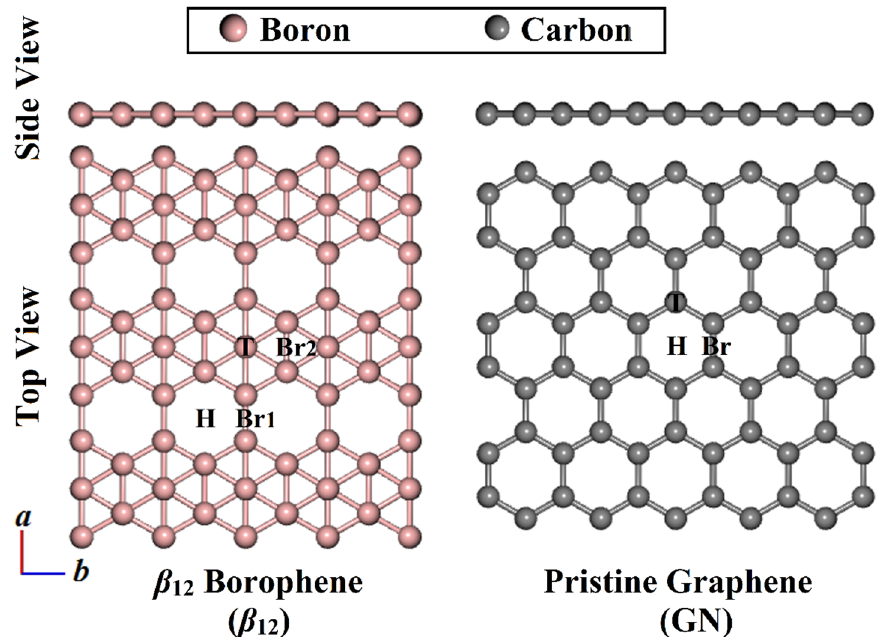
Figure 2. Side and top representations for optimized structures of 3 × 4 × 1 β 12 and 6 × 5 × 1 GN with the modeled adsorption sites. T, Br, and H refer to top, bridge, and hollow sites.